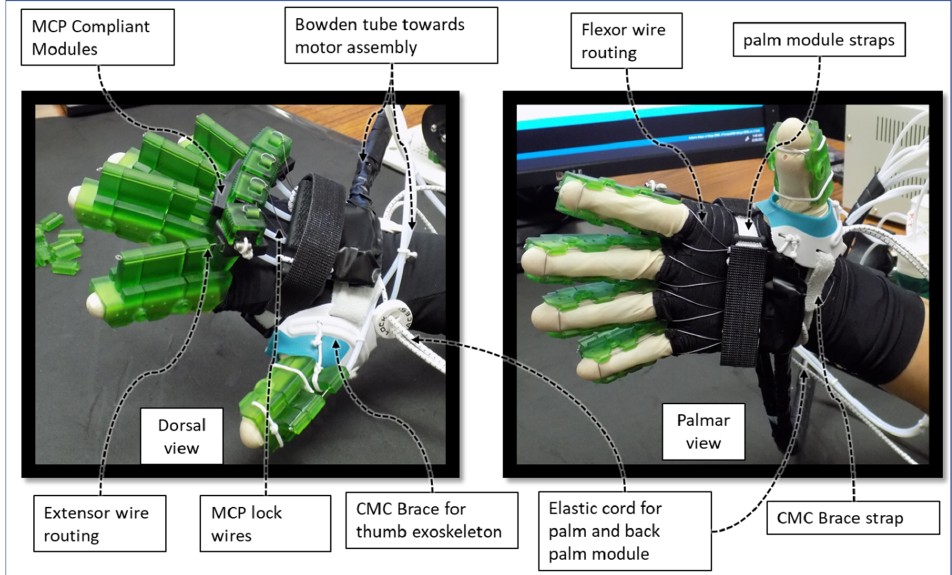
Figure 13. Palmar and dorsal view of the device worn by Participant-A.